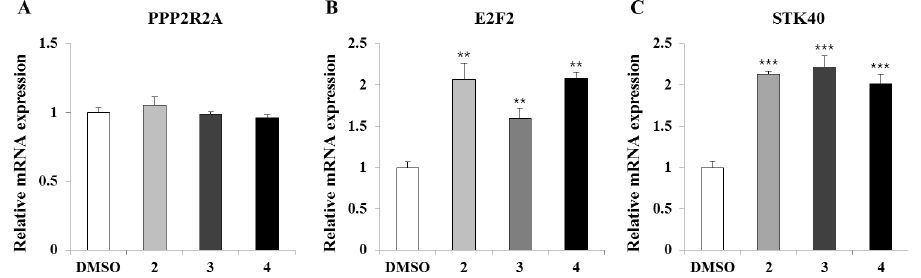
Fig 4. Expression of miR-31 target mRNAsfollowing compound treatment. A549 cells were treated with compounds1, 2, and 3 for 24 h. Total RNAs were extracted for subsequent qRT-PCR analysesof miR-31 target mRNAs. The Ct values for PPP2R2A (A), E2F2 (B), and STK40 (C) were normalized by the Ct value for GAPDH . Valuesrepresent mean ± SD. ** , p < 0.01; *** , p < 0.001 (Student’s t -test) comparedto expression in DMSO-treated